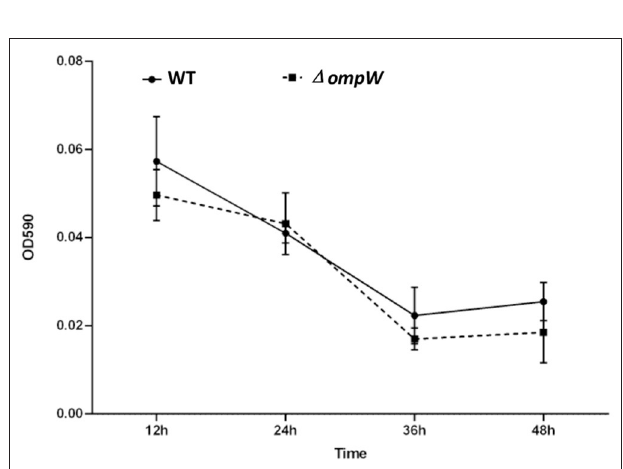
FIGURE 2 | Biofilms formation by the A. pleuropneumoniae strain and the 1 ompW mutant strain. Liquid was removed after static incubation at 37 ◦ C followed by the addition of a crystal violet dye solution. The biofilms were dissolved by adding a glacial acetic acid solution and the OD590 absorbance of each well determined. The experiment has at least three biological